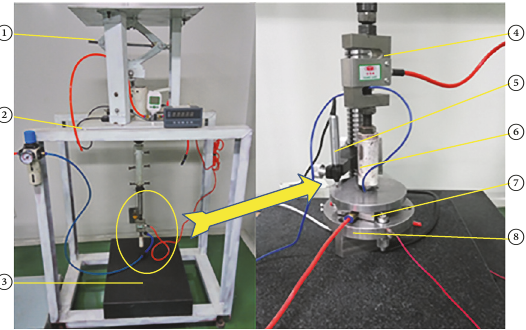
Figure 5: Bearing stiffness test rig. ( 1 ) Lifting jack. ( 2 ) Test bench. ( 3 ) Granite pedestal. ( 4 ) Force sensor. ( 5 ) Microdisplacement sensor. ( 6 ) Support bars. ( 7 ) Tested aerostatic bearing. ( 8 ) Bearing